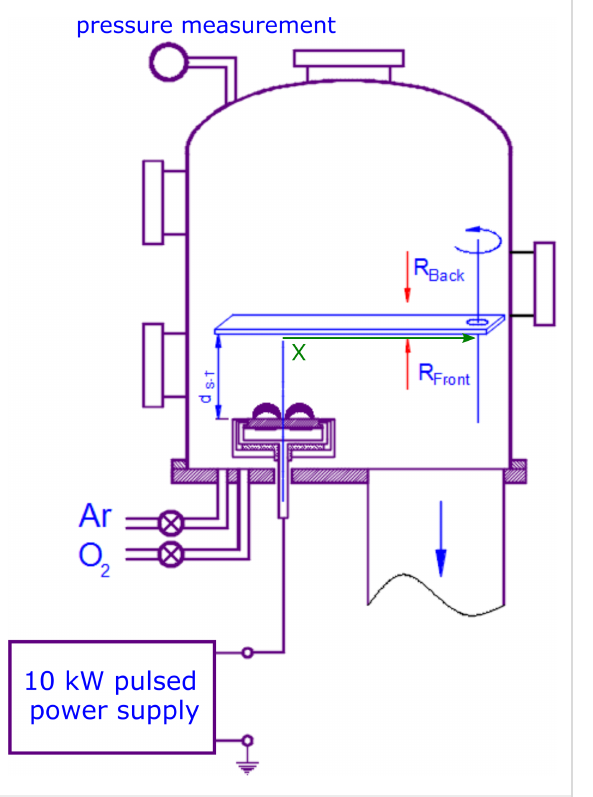
Figure 2: View of the working magnetron and glass strip substrate positioned over the Zn/Al target.